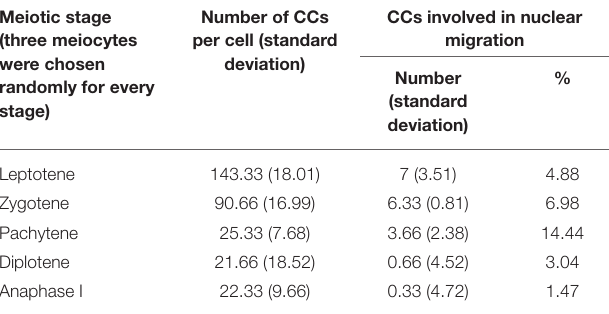
TABLE 1 | The number of CCs in tobacco meiocytes at different meiotic stages. Meiotic stage (three meiocytes were chosen randomly for